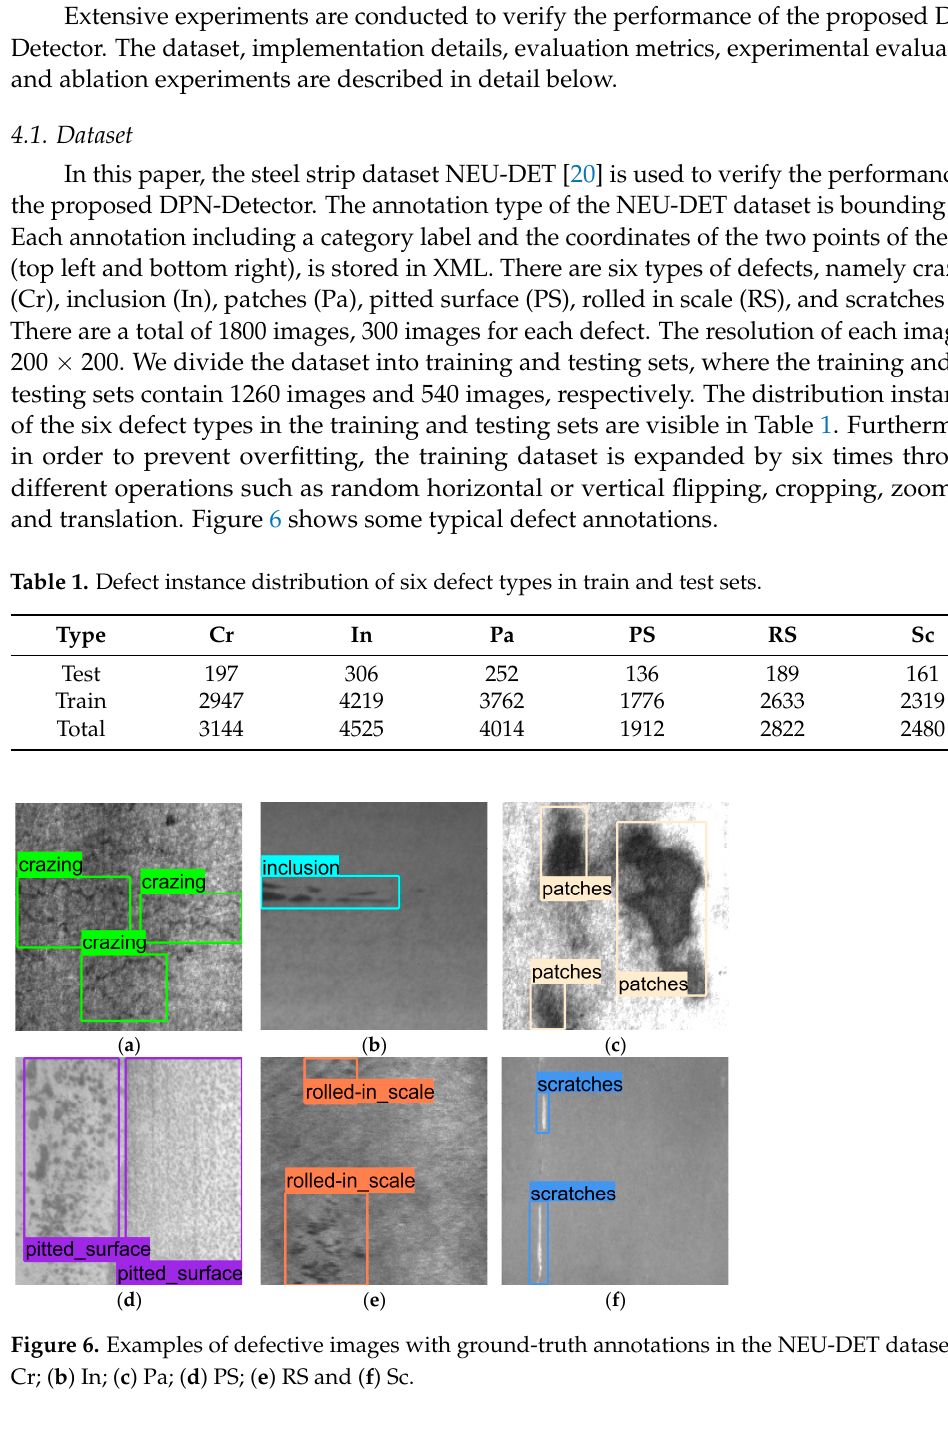
4.2. Evaluation Metrics Both classification accuracy and predicted location accuracy need to be evaluated in defect detection. Therefore, the 𝐹1 and average precision ( 𝐴𝑃 ) are used to evaluate the classification and location performance of model. In addition, mean average precision